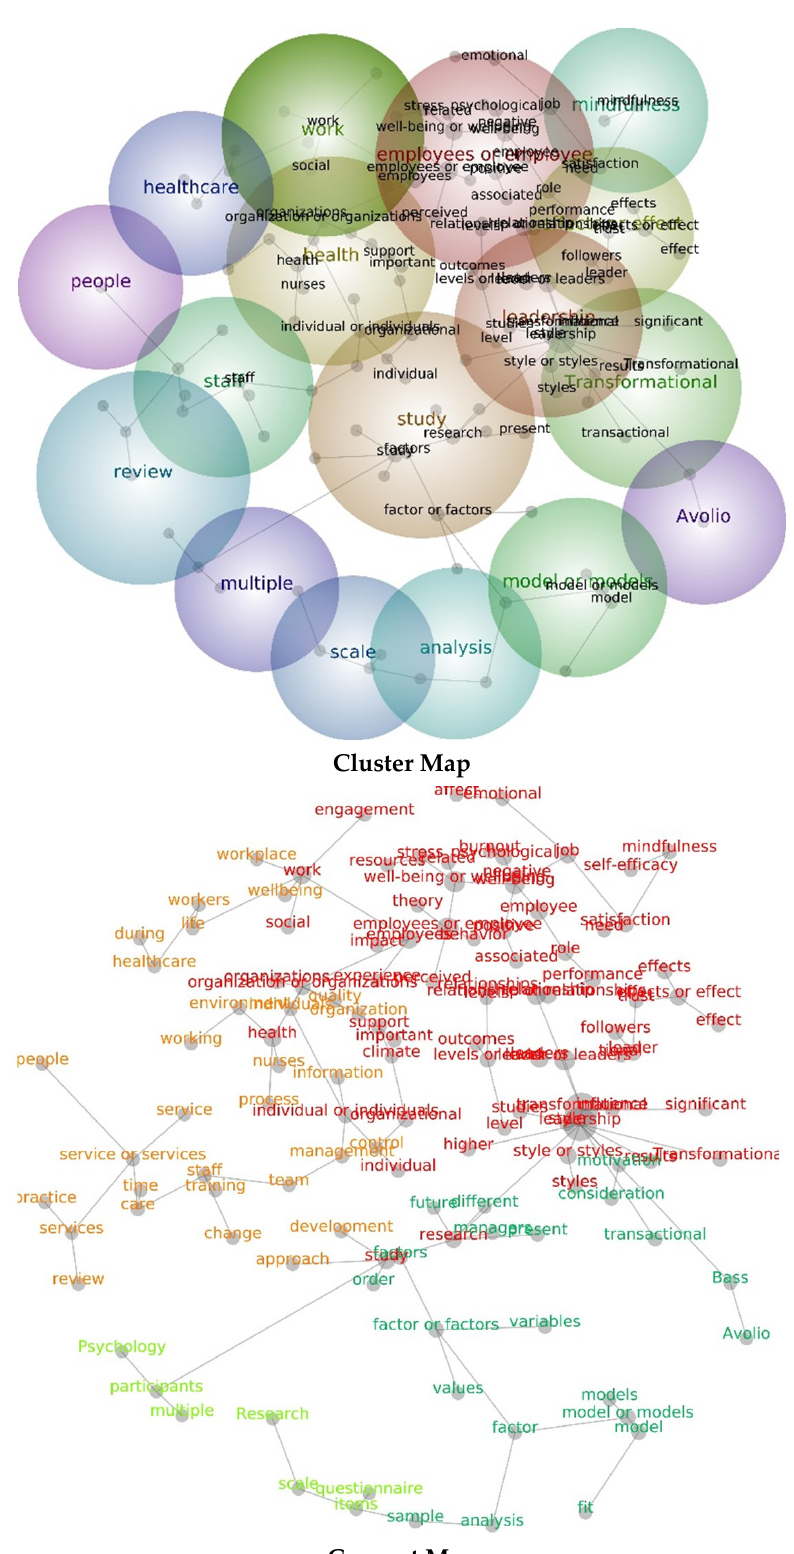
Figure 4. Theme and concept map for the selected articles on transformational leadership and psychological well-being. The relative size of each theme circle is the boundary for clustered concepts; warm colors (red, orange) indicate the most important themes and cool colors (blue, green) denote less important themes.